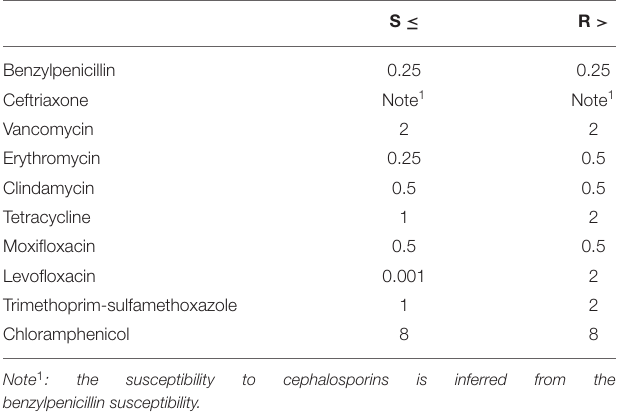
TABLE 2 | EUCAST MIC breakpoints for Streptococcus groups A, B, C and G